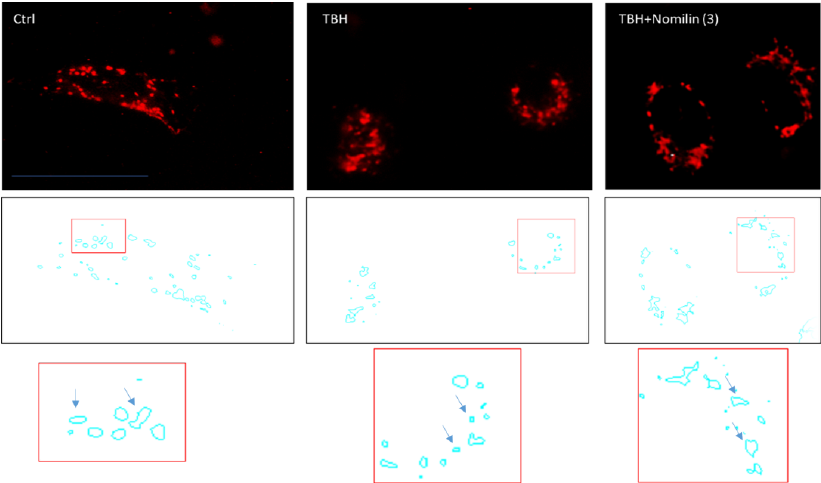
Figure 9. Mitochondrial morphology analysis. Representative fluorescence microscopy images of mitochondria stained with the MitoTracker Deep Red in untreated cells (Ctrl) or treated with 500 µM of TBH alone or in combination with nomilin ( 3 ) at 0.1 mg/mL for 2 h.